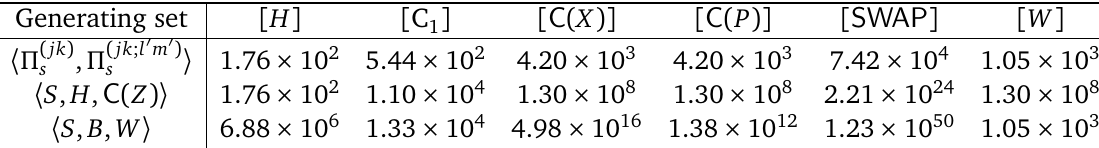
Table 3: Difficulty weights of Pauli cosets of gates for the case where Majorana- Pauli tracking methods are utilized for two-sided hexon architectures with the 〈 3,4,1,2,6,5 〉 labeling configuration. We compare the weights for gates syn- thesized from the generating sets of operations given by MZM measurements ( jk ; l (cid:48) m (cid:48) ) 〈 Π ( jk ) , Π s s